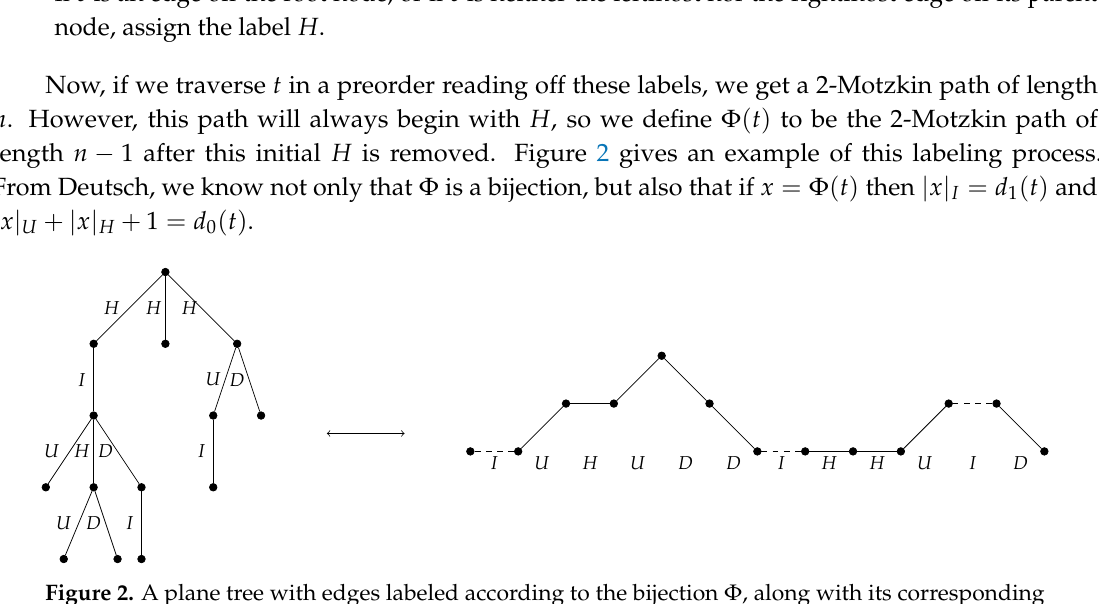
Figure 2. A plane tree with edges labeled according to the bijection Φ , along with its corresponding 2-Motzkin